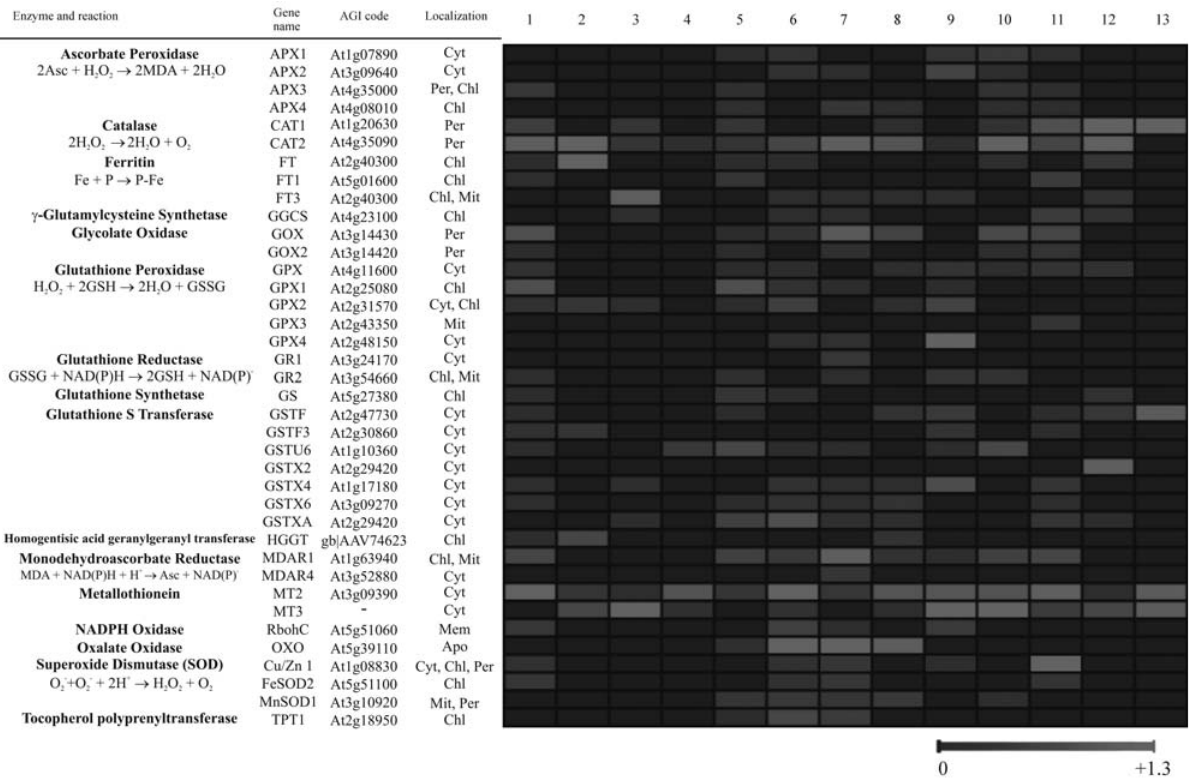
Figure 2 - Expression profile of enzymes and polypeptides of antioxidant system of Citrus sinensis variety ‘Pera IAC’ submitted to several treatments (1) Leaf cDNA from non-infected tissue; (2) Leaf cDNA from young tissue; (3) Bark cDNA of healthy plants growing in green house; (4) Flower cDNA of healthy plants growing in green house; (5) Fruit cDNA of development stage 1; (6) Fruit cDNA of development stage 2; (7) Fruit cDNA of development stage 3; (8) Fruit cDNA of development stage 4; (9) Fruit cDNA of development stage 5; (10) Fruit cDNA of development stage 6; (11) Leaf cDNA from tissue infected by Xylella fastidiosa stage 1; (12) Leaf cDNA with 30 days after infection by X. fastidiosa ; and (13) Leaf cDNA from tissue infected by Citrus leprosis stage 1. All data were multiplied by 10 3 to GEPAS online tool